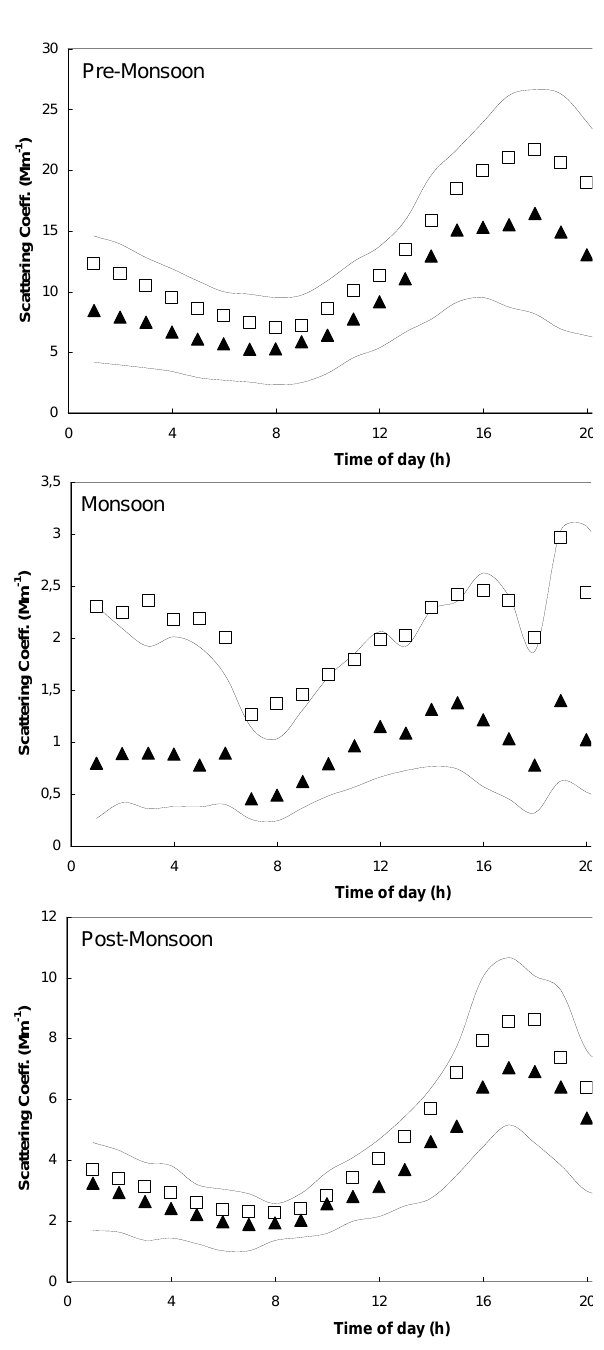
Fig. 2. Diurnal variability of hourly averaged (squares) and median (triangle) scattering coefficient values at NCO-P for pre-monsoon, monsoon and post-monsoon periods. Dashed lines represent 25 and 75-percentile,